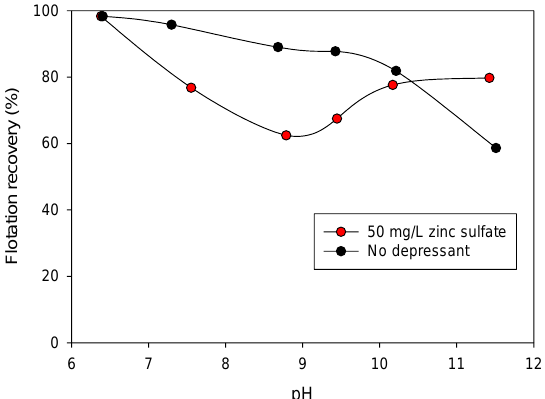
Figure 33. Chalcopyrite recovery vs. pH (2g with a size of − 38 µm in 5 × 10 −4 mol/L of isopropyl sodium xanthate as a collector; 200 mL of distilled water, pH fixed with NaOH or HCl and 20 mg/L DF250) (adapted from Cao et al. [142]).